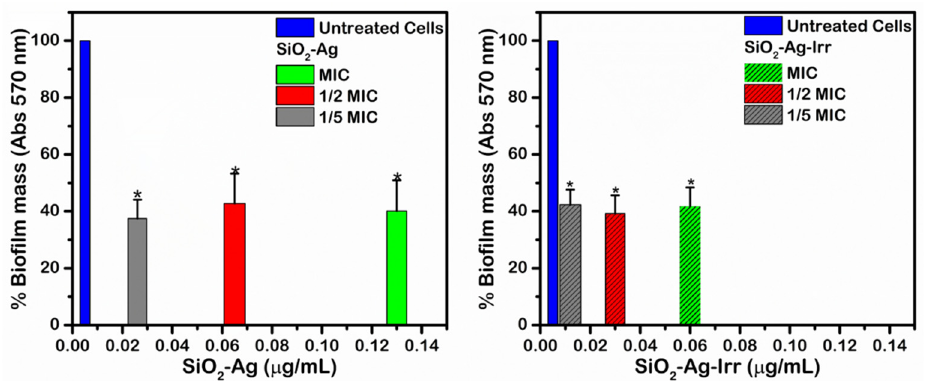
Figure 3. Biofilm mass growth of A. niger in presence of SiO 2 -Ag ( left ) and SiO 2 -Ag-Irr ( right ) compared to untreated cells (green striped column), at concentration equal to MIC (green columns), ½ MIC (red), and 1/5 MIC (grey).